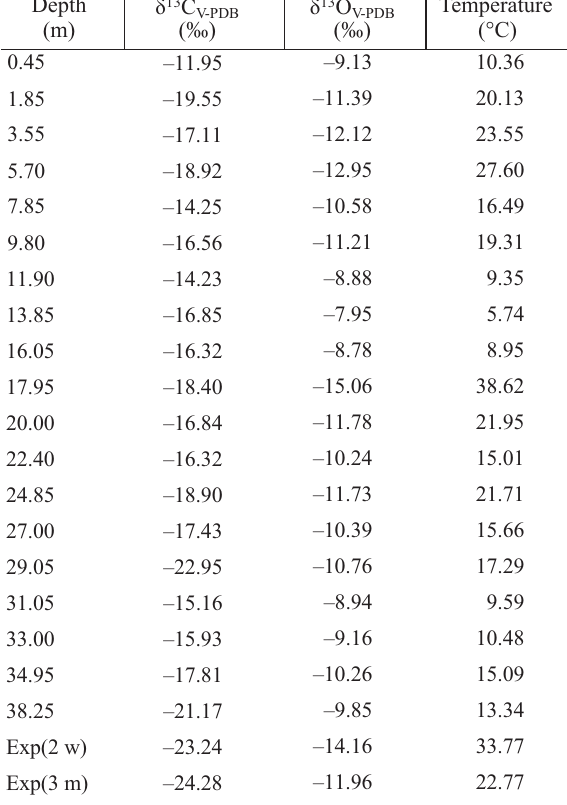
Table 1. Stable isotope composition and the calculated equilibrium temperatures of ash sediments.